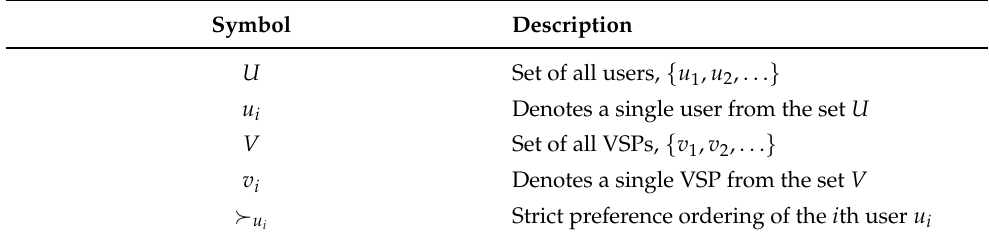
Table 5. Symbols and